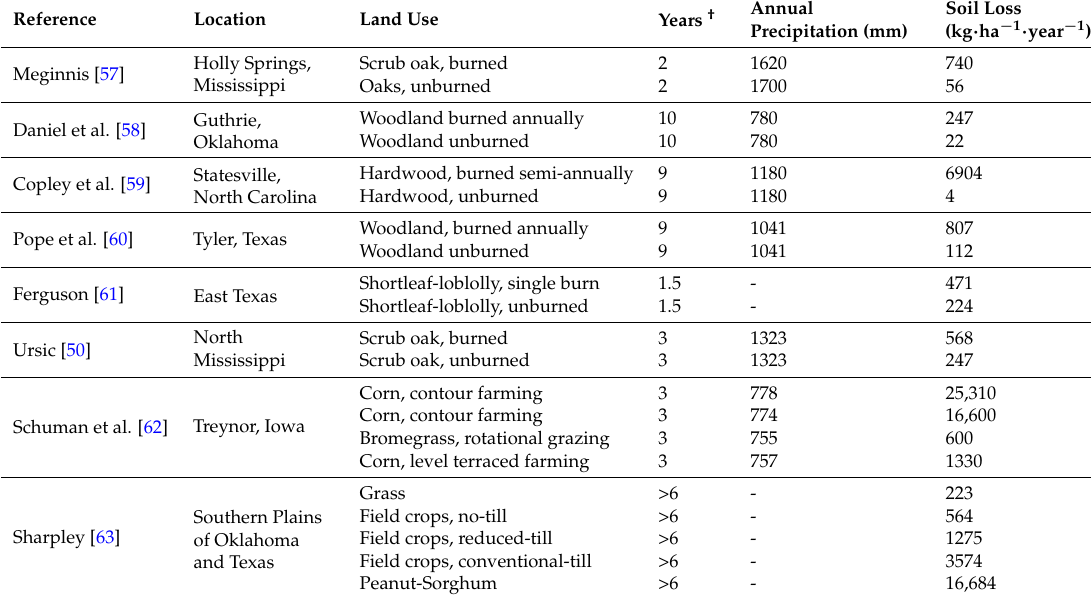
Table 6. Annual soil losses reported from different land use systems in the United